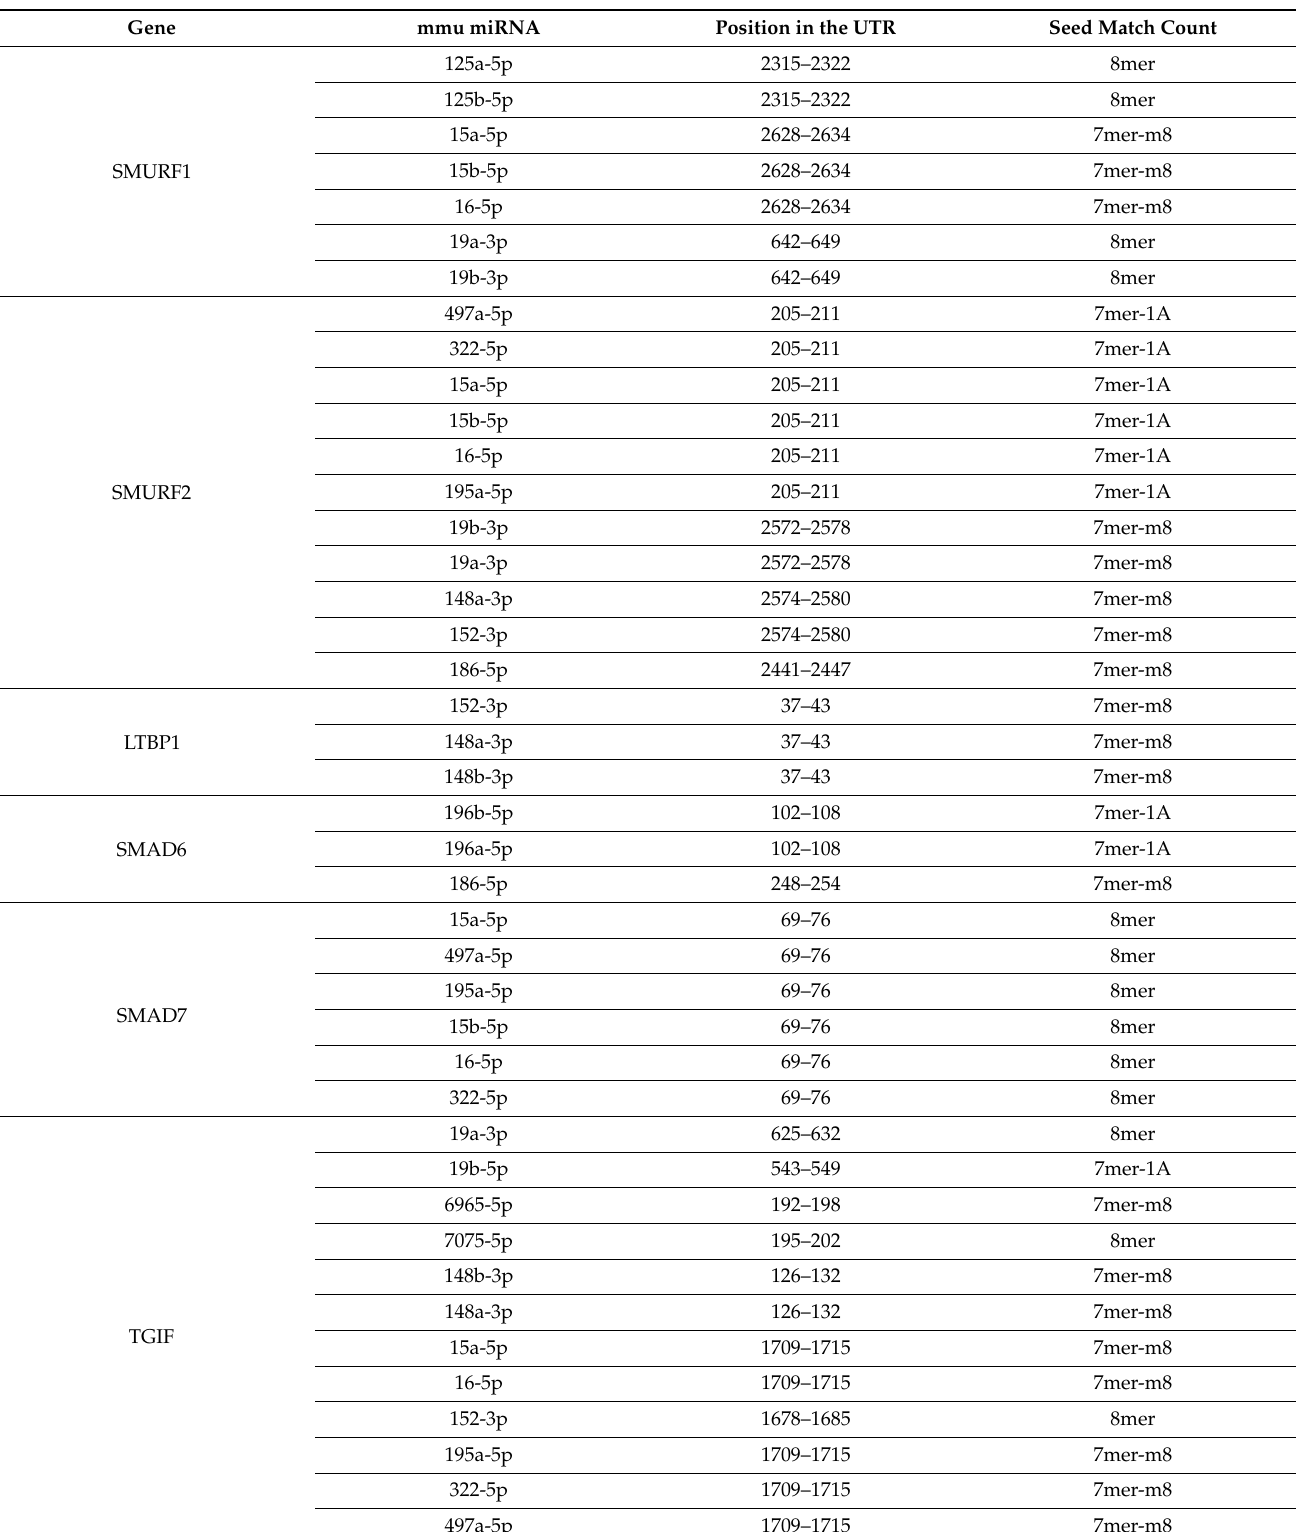
Table 1. Potential binding combination between inhibitors of TGF- β /SMAD signal pathway and mmu